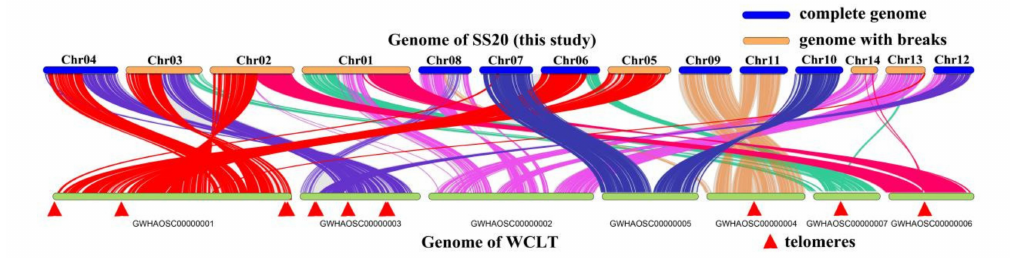
Figure 3. Collinearity between Wolfipoira hoelen SS20 and WCLT [24]. The genome of W. cocos was sequenced using a combination of ABI3703, 454-Titanium, and Illumina GAII, and showed a relatively complete genome [29]. In relative terms, 67.35% (7722) of proteins of W. hoelen have homologous proteins in W. cocos . There may have been a chromosome translocation from Chr7 to Chr13 of W. hoelen compared with W. cocos (Figure S6). The genome of L. sulphureus was sequenced by illumina that showed a relatively bad assembly [30] and a distant genetic relationship. In relative terms, 46.41% (5670) of proteins of W. hoelen have homologue in the genome of L. sulphureus . Only 29.34% genes on Chr14 of W. hoelen have collinearity with the species W. cocos and no homologous genes with L. sulphureus (0%); however, 70–80% of genes on the other chromosomes have homologue in W. cocos and 35–70% in L. sulphureus